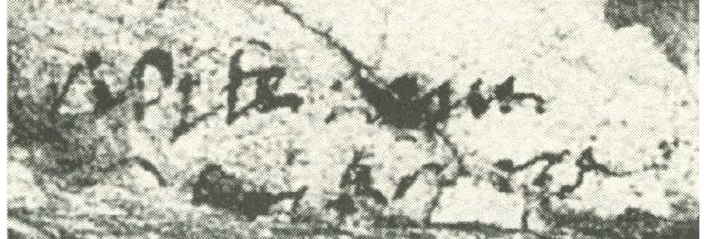
Fig. 4 – Signature n. 4 on page 1 of Shakespeare’s Last Will (1616)